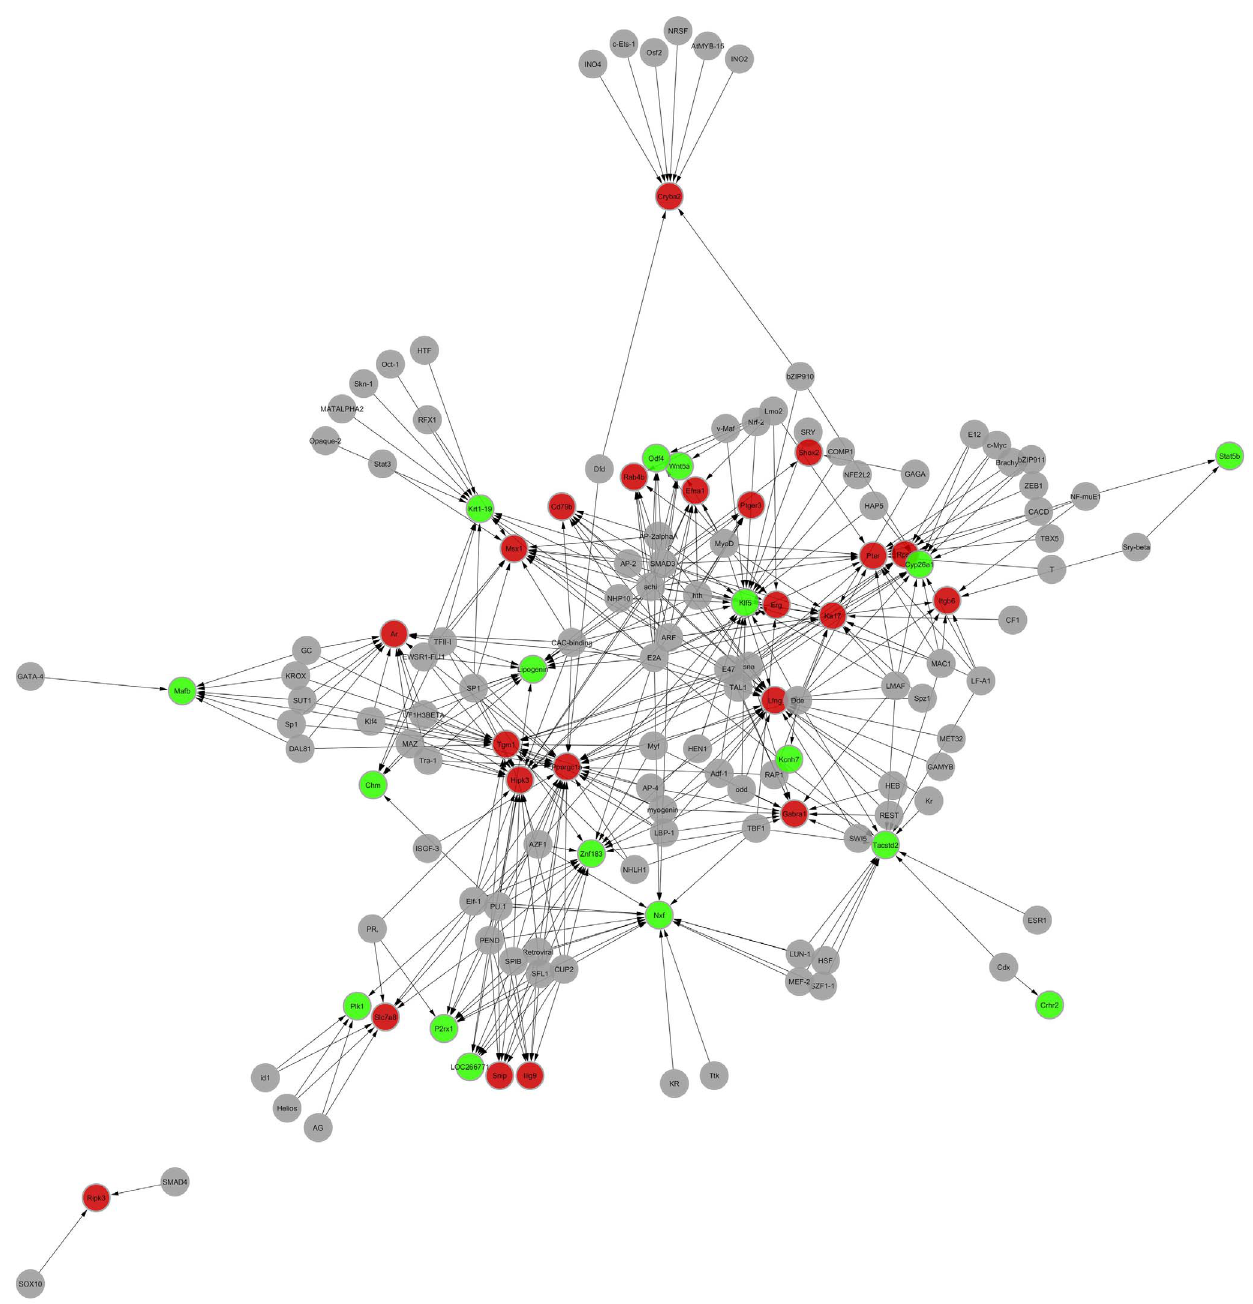
Figure 4. Visual diagram of the differential gene transcription regulation network of the 21-day stress group in comparison with the control group. The red represents up-regulate genes, the green represents down-regulate genes, the grey represents transcription factor. The arrow indicates the direction of TF target genes (TFT) regulated by transcription factor (TF). the network structure and their common TFs (Table 3). Regula- tion network structure diagrams are shown (Figure 3 and Figure 4). Red and green represent up-regulated and down-regulated genes, respectively, and gray represents TF. For regulation direction, TF to TFT was expressed by an arrow.